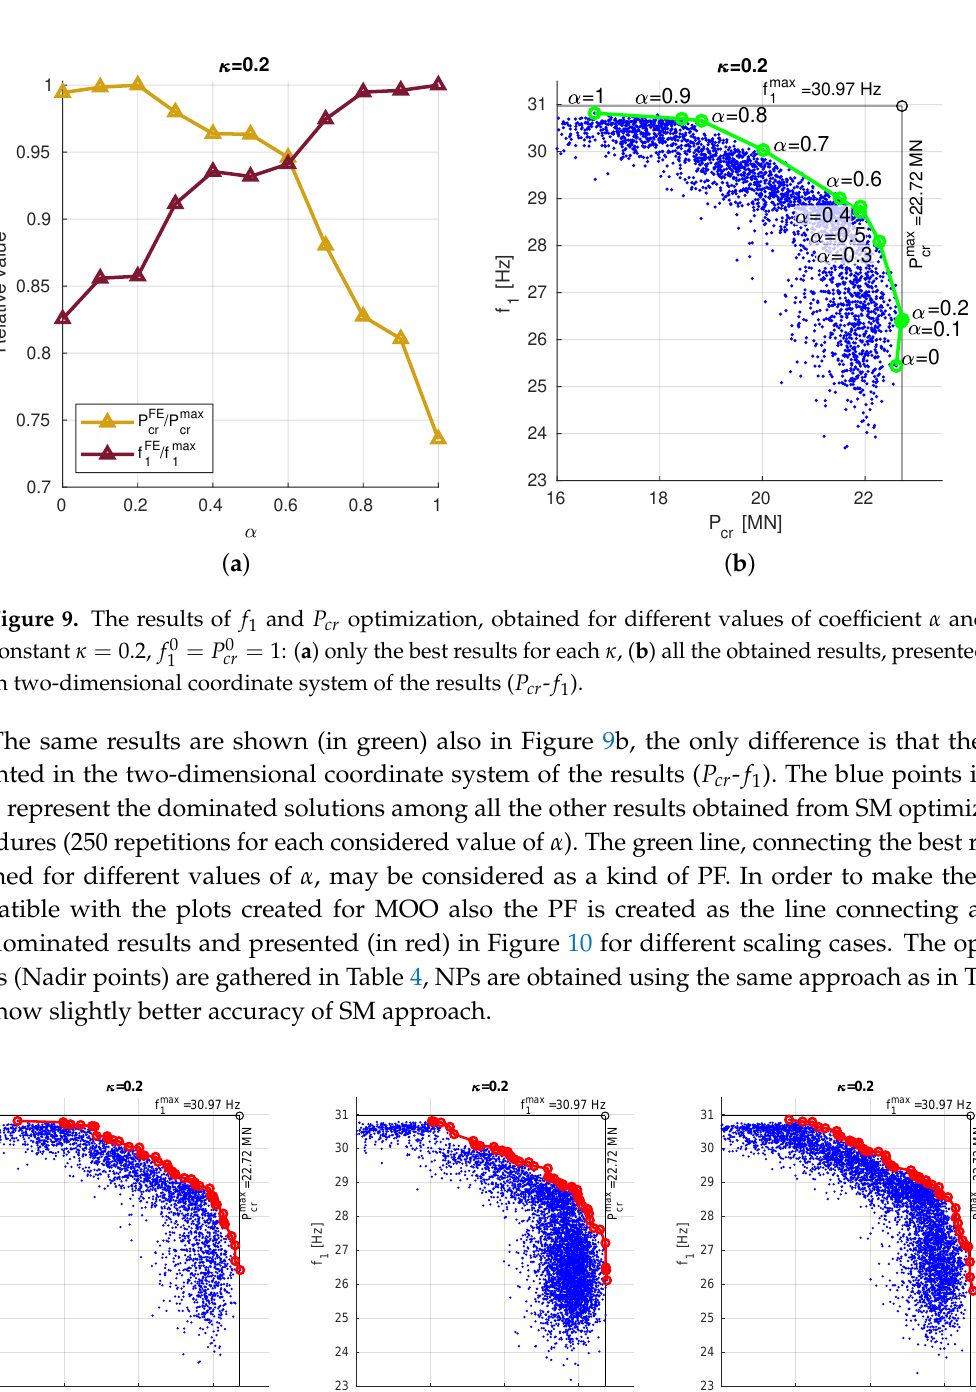
= f max , P 0 cr = P max cr 1 1